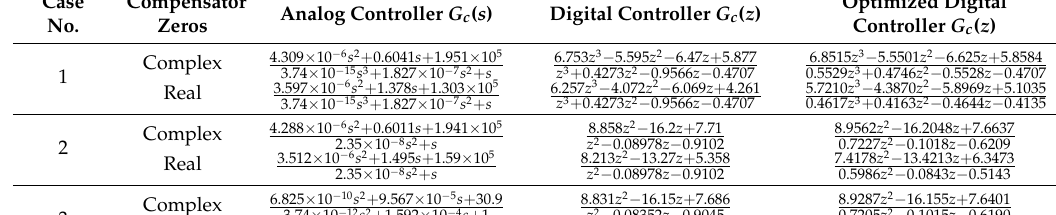
Table 2. Controllers’ transfer functions.